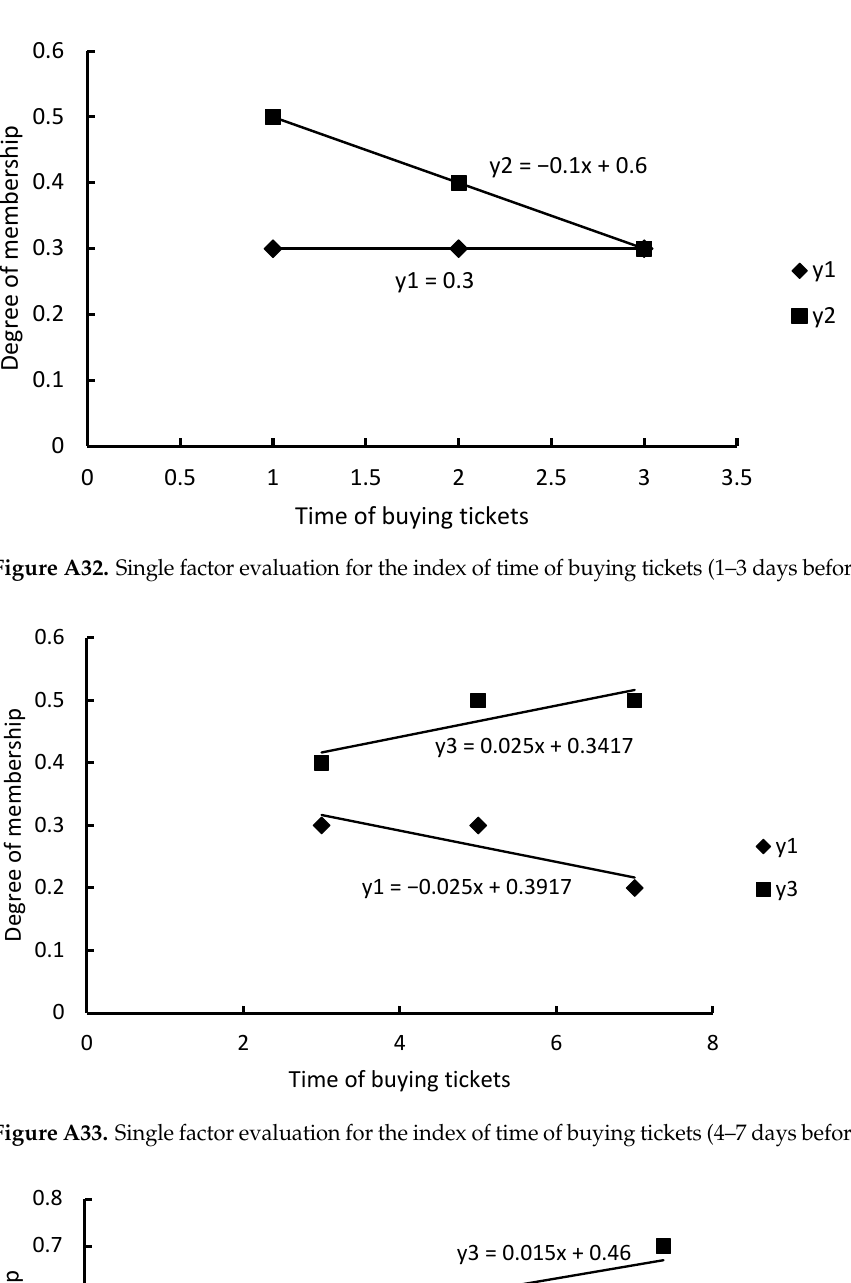
Figure A31. Single factor evaluation for the index of time of buying tickets (1 day before depar- ture).